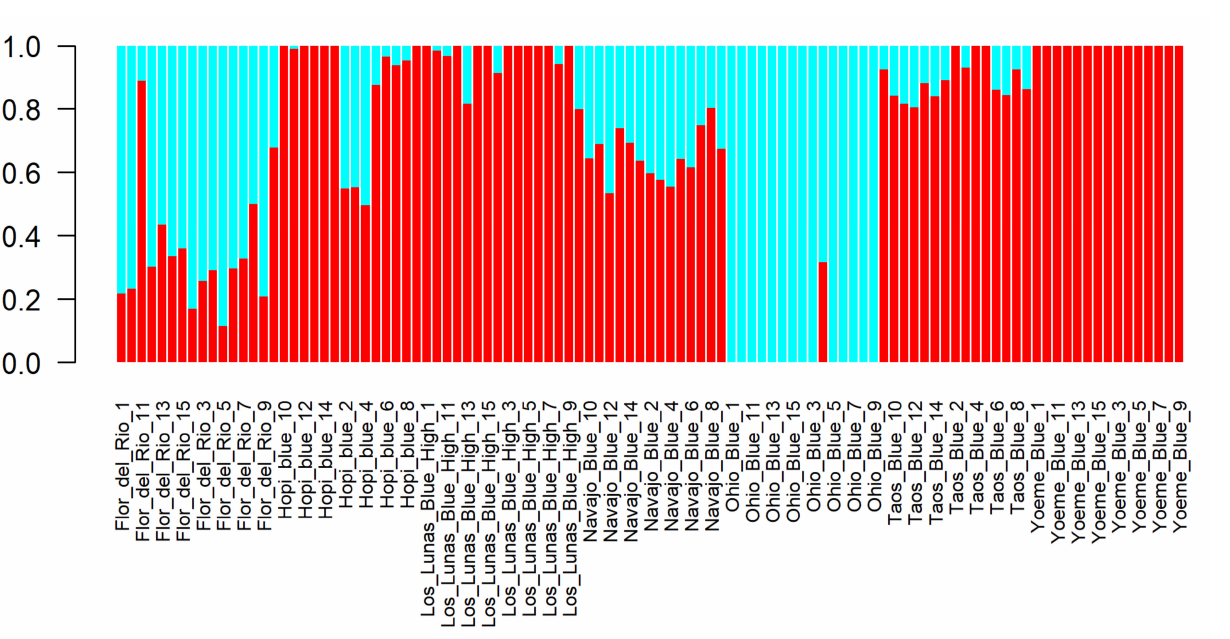
Figure 4. Barplot displaying genetic structure distribution of two groups (K = 2) identified based on lowest cross-validation (CV) error. Group 1 comprised of blue maize landraces of southwest origin and group 2 consists of Midwestern Ohio